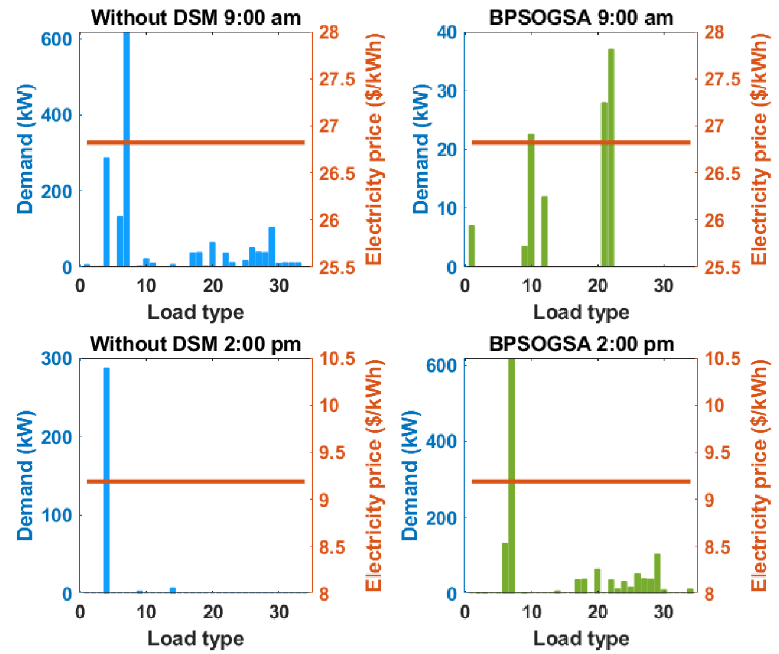
Figure 10. Scheduling of load types before and after BPSOGSA from 09:00 to